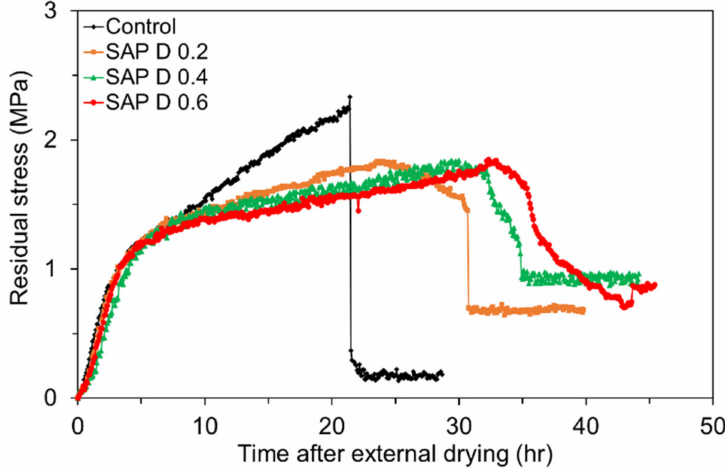
Figure 19. Restrained stress development in mortar ring specimens with different SAP contents when external drying initiated immediately final